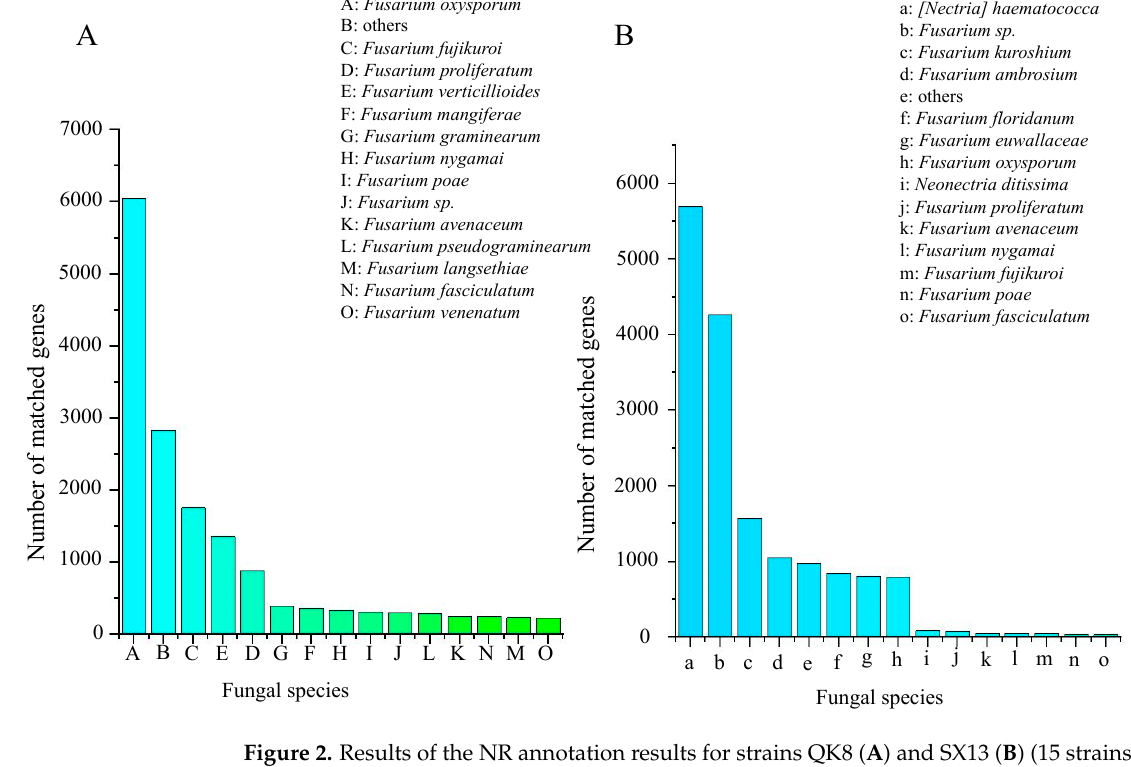
counted 6201 and 6509 genes, respectively (Tables S6 and S7). Except for some genes with with the highest proportion of the genome of the two strains was related to